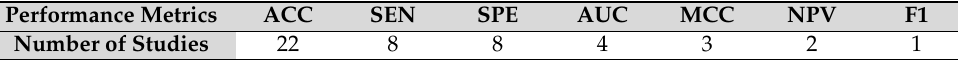
Specificity, MCC: Matthew’s correlation coefficient, NPV: Net present value, F1: Dice similarity coefficient).